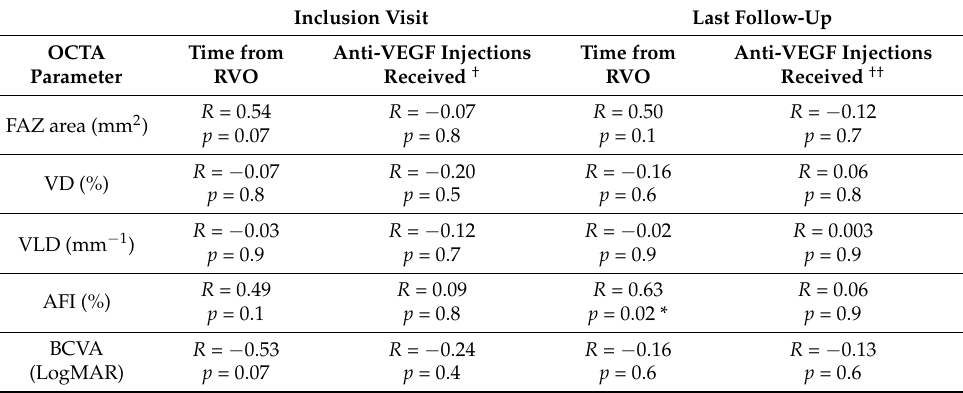
Table 3. Correlation of OCTA parameters and best-corrected visual acuity (BCVA) with the duration of retinal vein occlusion (RVO) and the number of anti-vascular endothelial growth factor (VEGF)